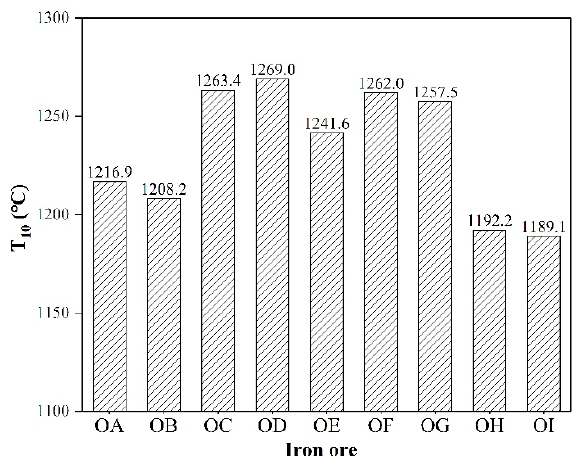
Figure 5. Results of generation temperature of effective liquid phase.